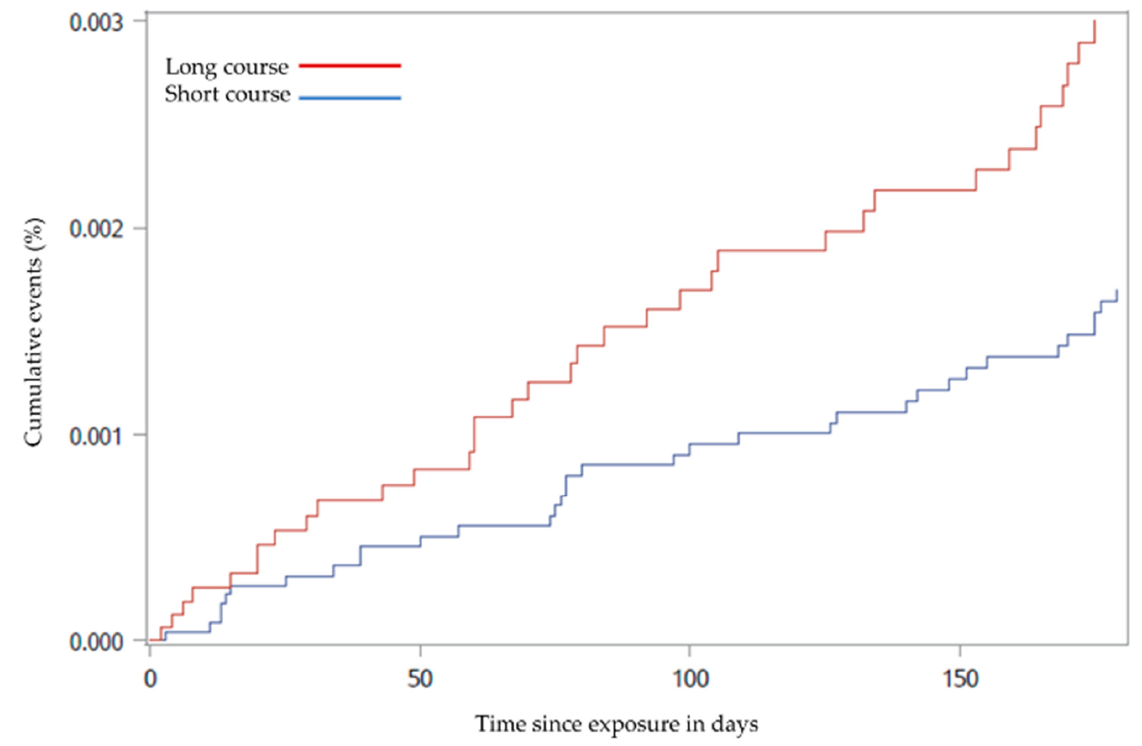
Figure 2. Cumulative incidence curve for venous thromboembolism from baseline until the first event within the 6-month follow-up period among chronic obstructive pulmonary disease outpatients treated with long vs. short oral corticosteroid treatment courses from 2010 to 2018 ( p = 0.031). The curve is adjusted for death as a competing risk.